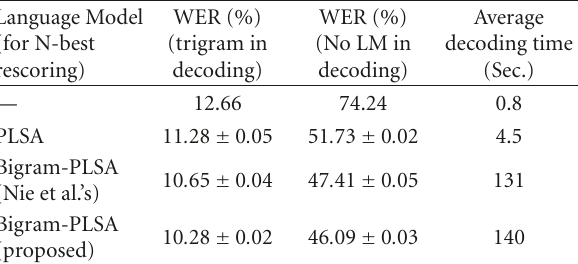
Table 3: Average word error rates of the CSR system using PLSA- based language models with and without trigram language model in decoding.